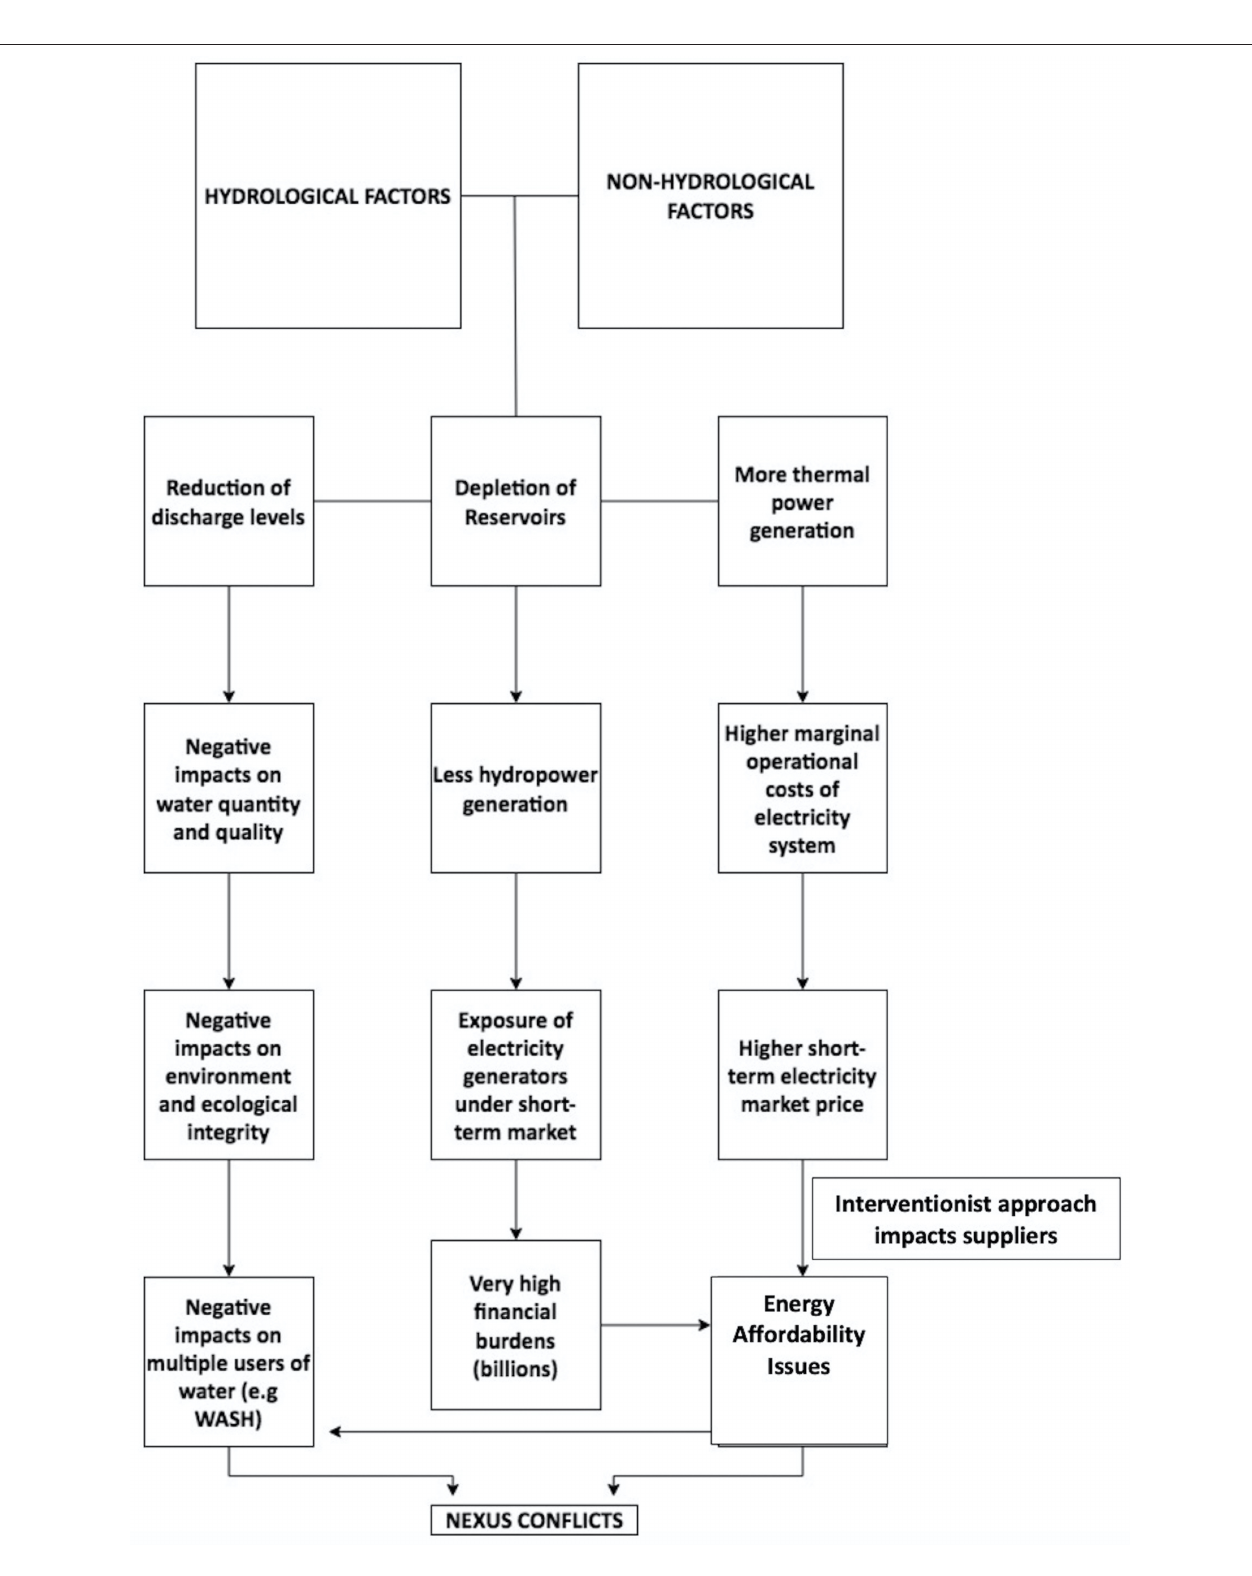
FIGURE 2 | Cascading impacts of water-electricity nexus in Brazil.